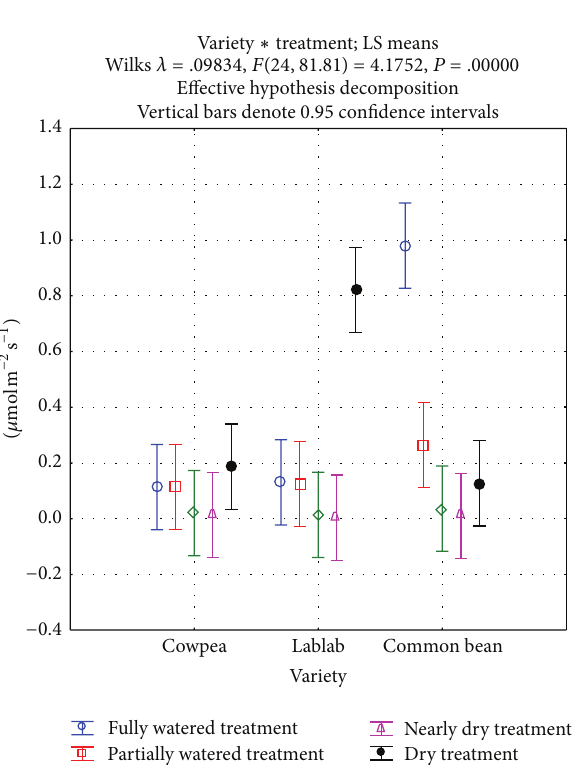
Figure 8: Photosynthesis rate on 55 DAP.